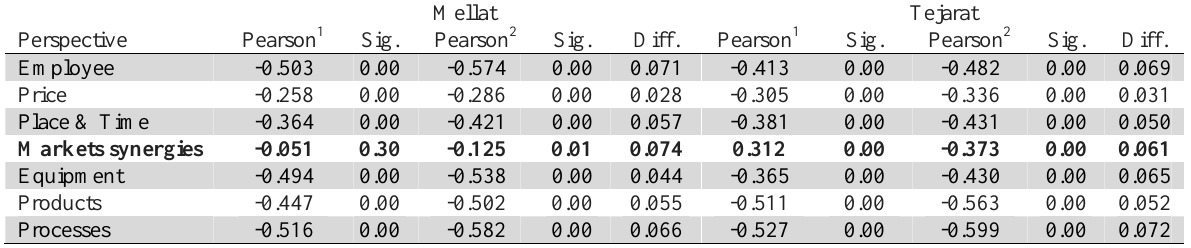
The results of Pearson correlation test between various bank perspectives and customer behavior Mellat Tejarat Perspective Pearson 1